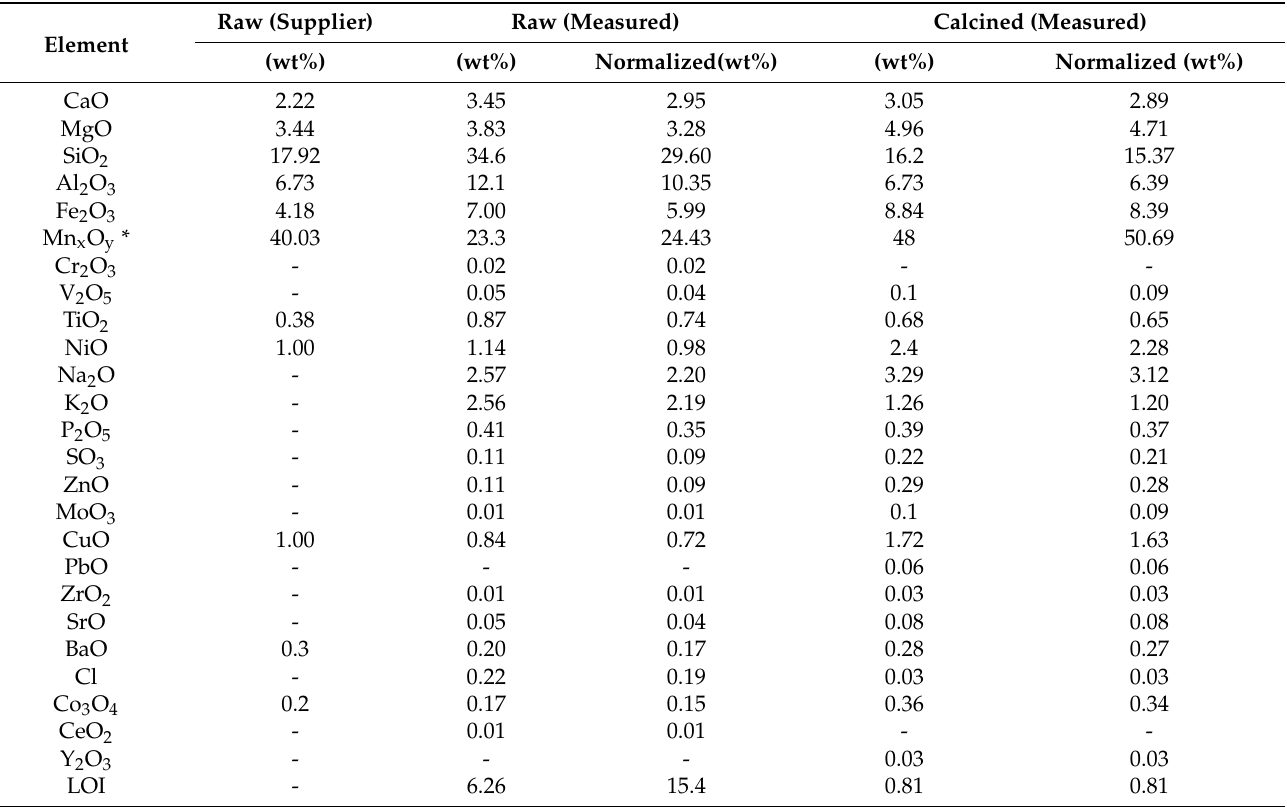
Table 2. XRF analysis from supplier and measurements in this study.